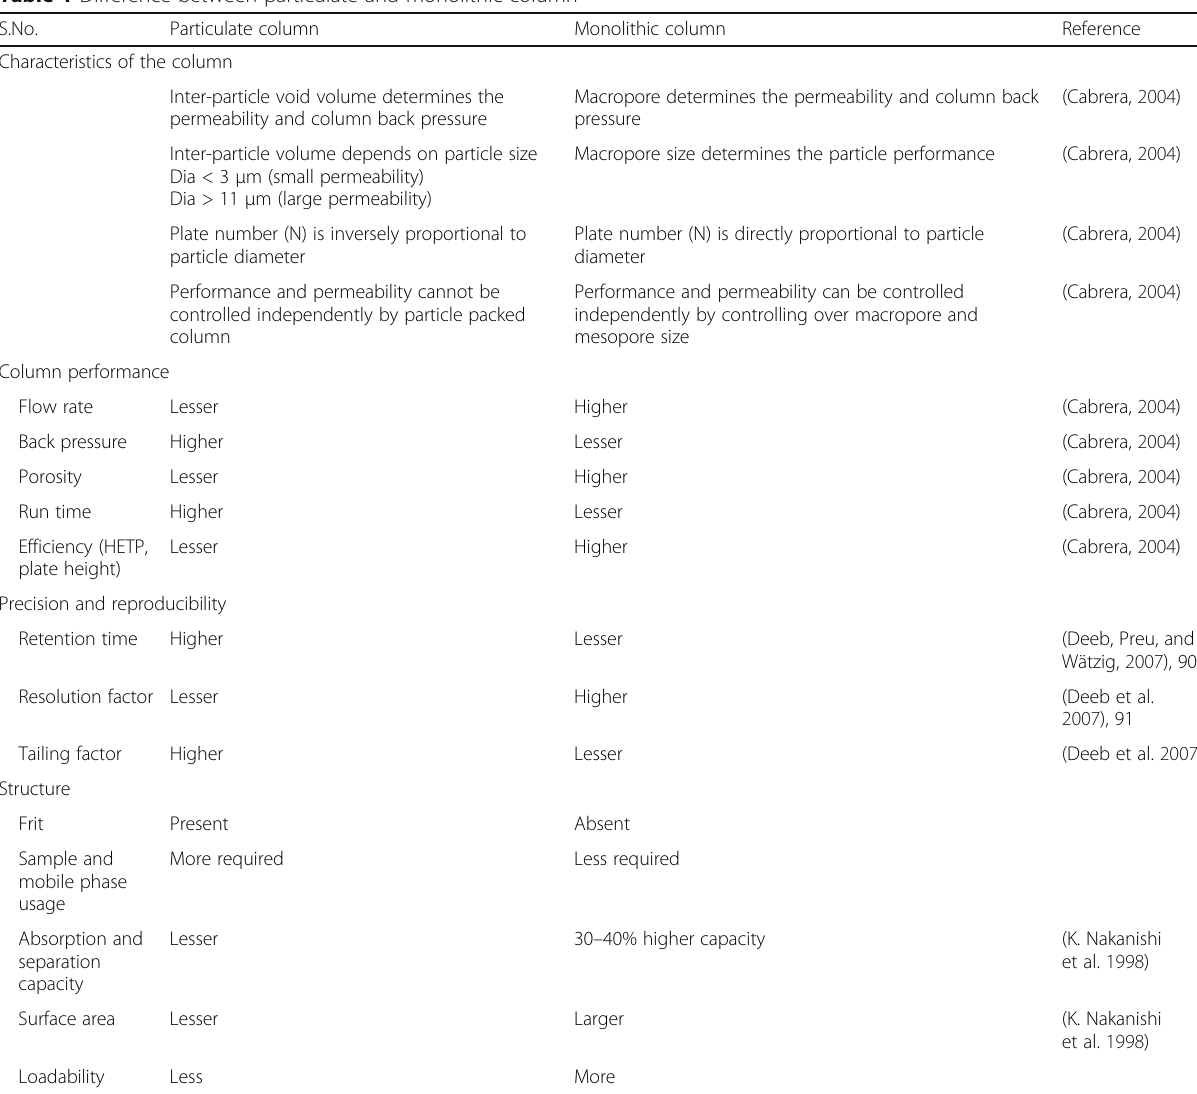
Table 1 Difference between particulate and monolithic column